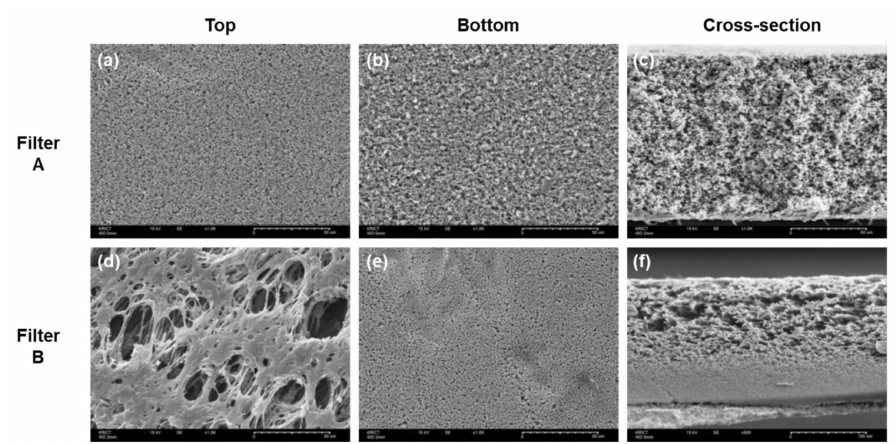
Figure 1. SEM images of filters A ( a – c ) and B ( d – f ). Top view ( a , d ), bottom view ( b , e ), and cross- section view ( c , f